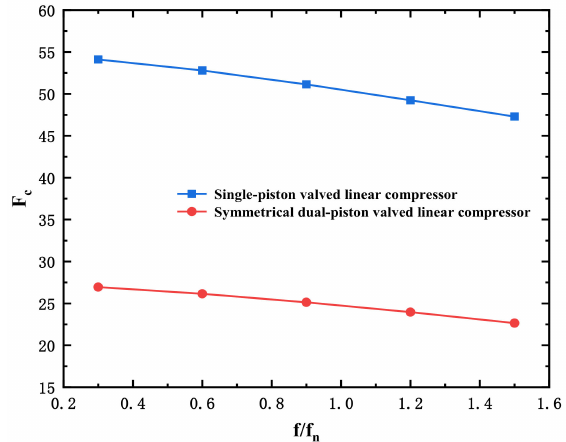
Figure 9. Variances of the two types of linear compressors under a different